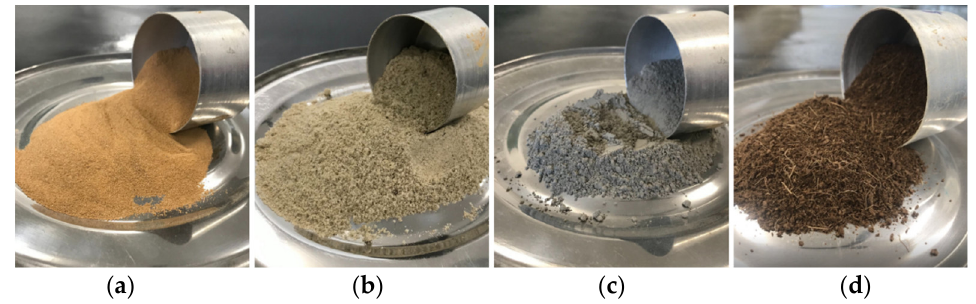
Figure 1. Raw materials used: ( a ) soil; ( b ) sand; ( c ) Portland cement; ( d ) coconut fiber. Alvorada area in the Jardim Belvedere neighborhood located in the city of Volta Redonda